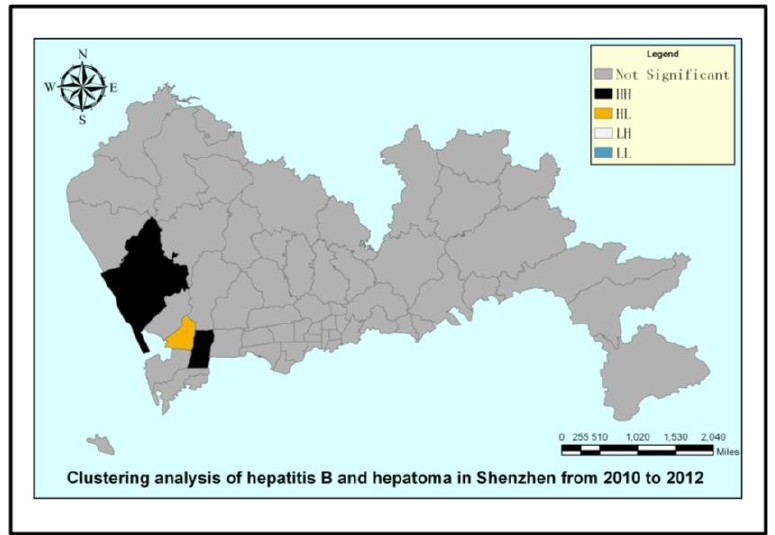
Figure 4. Clustering analysis of hepatitis B and hepatoma in